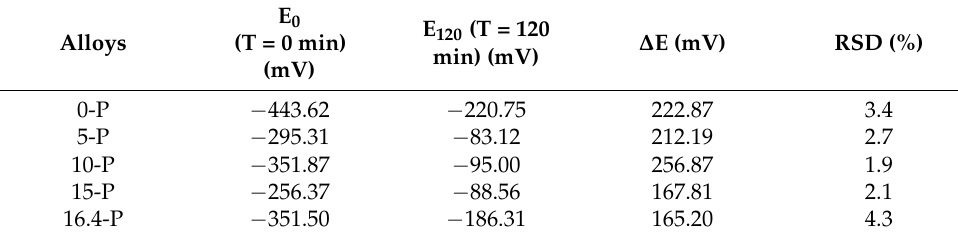
Table 2. Values of the open circuit potential over time on the surfaces of the alloy samples.